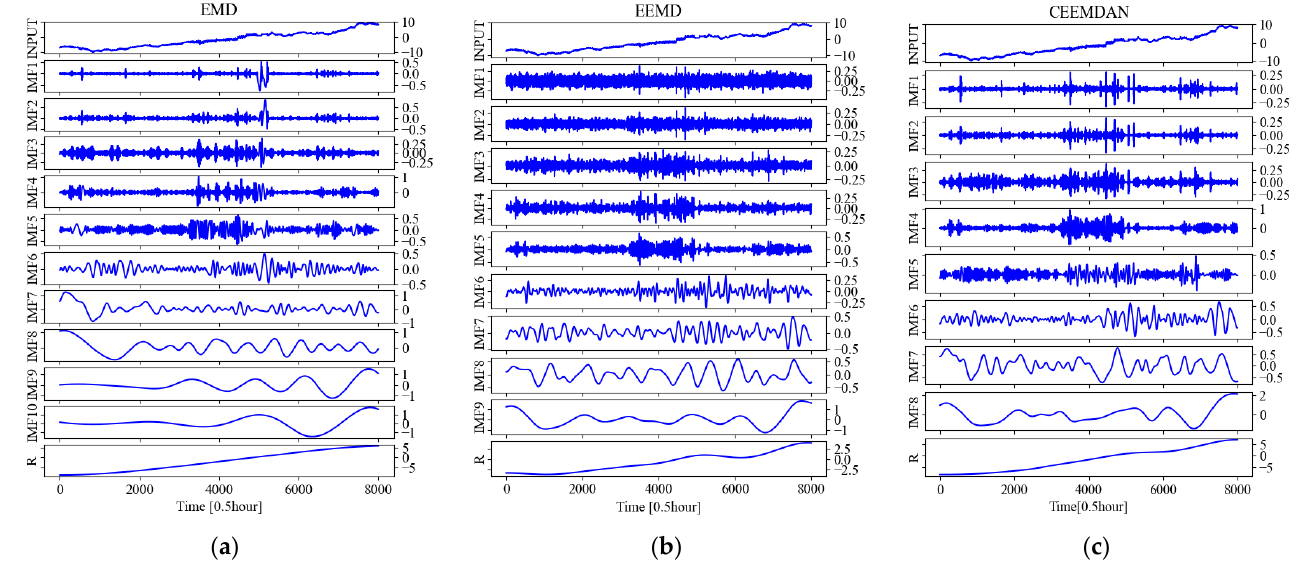
Figure 6. The results obtained after various decompositions for the temperature time series at 0.5 m below the subgrade surface of the right shoulder of section K3588 + 100 of China National Highway G109. ( a ) The IMFs and R obtained after EMD; ( b ) The IMFs and R obtained after EEMD; ( c ) The IMFs and R obtained after CEEMDAN.